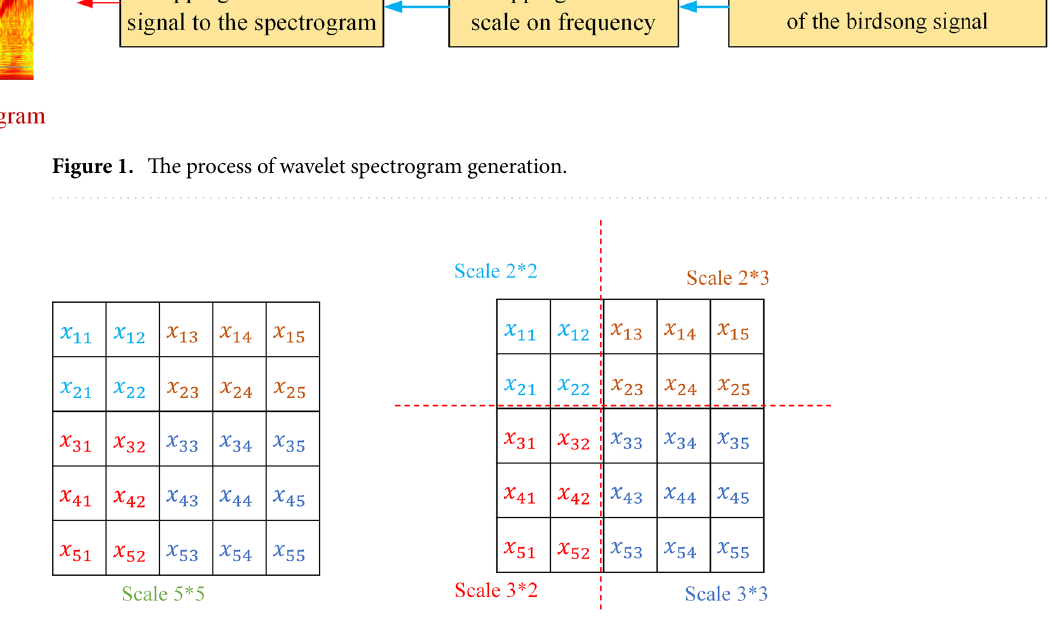
Figure 2. The 5*5 convolution kernel decomposition